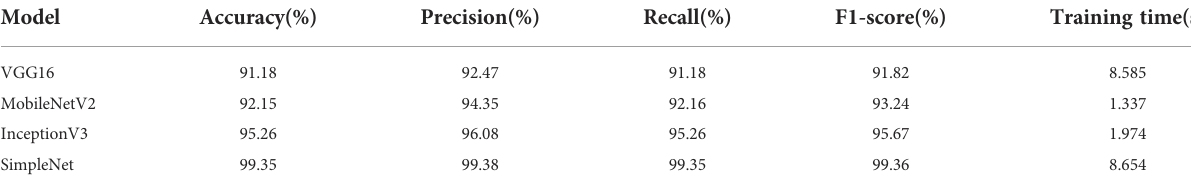
TABLE 7 The overall evaluation metrics of four CNN models for rice leaf